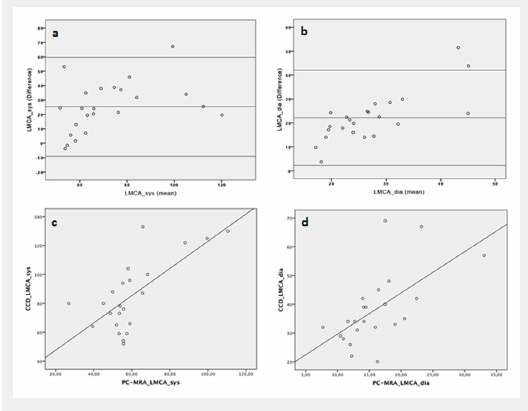
Figure 4 Bland-Altman analysis of colour-coded duplex sonography (CCD) compared with phase contrast magnetic resonance angiography (PC-MRA) of the left middle cerebral artery (MCA) showed 22 of 23 points within 1.96 for peak systolic velocity (PSV) (a) with a bias of 19.55 and 1.96 standard deviations limits of agreement of –7.44 and 46.54 and 21 of 23 points within 1.96 SD for end diastolic velocity EDV (b) with a bias of 6.68 and 1.96 SD limits of agreement of –3.00 and 16.36. The Spearman’s r for PSV was 0.555 (c) and for EDV was 0.673 (d), both significant at the 5% level.